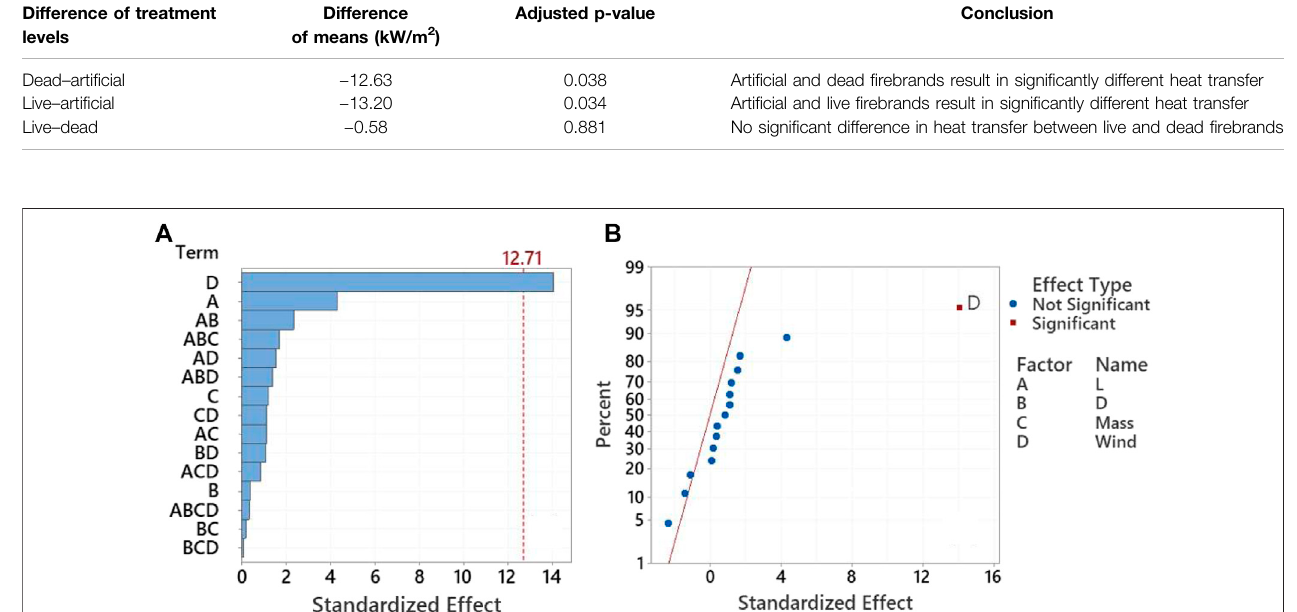
Frontiers in Mechanical Engineering |